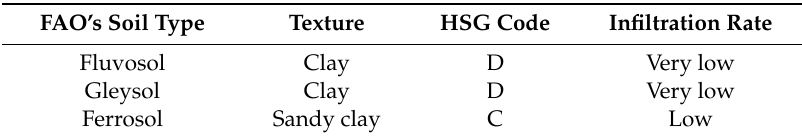
Table 1. Hydrologic soil group classification for the study area. The area was mainly covered with HSG C (sandy clay) and HSG D (clay) soil